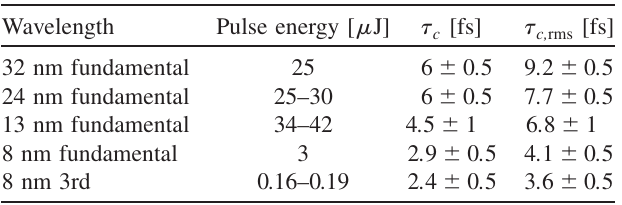
TABLE I. The coherence time (cid:2) given as the HWHM of the Gaussian functions shown in Fig. 5; (cid:2) is calculated with Eq. c; rms